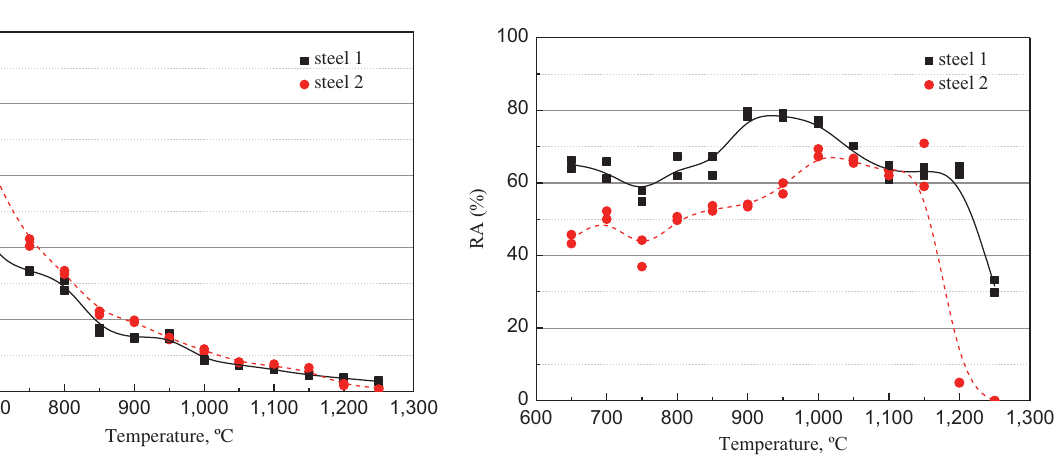
Figure 3: Peak stress as a function of the temperature of high-Mn austenitic steels.